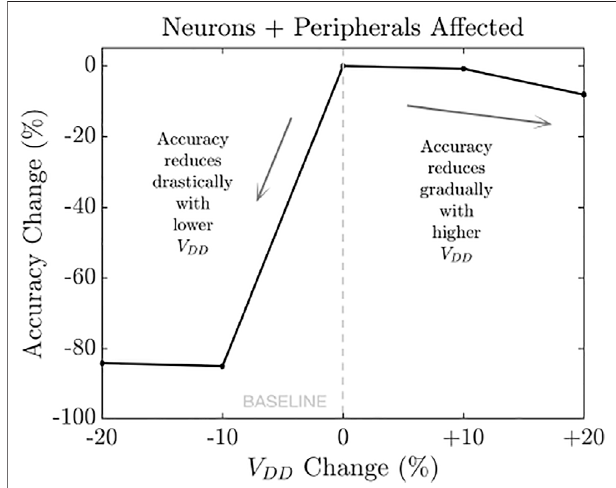
FIGURE 11 | Change in classi fi cation accuracy with V DD change for entire system (neurons and peripherals) (Attack